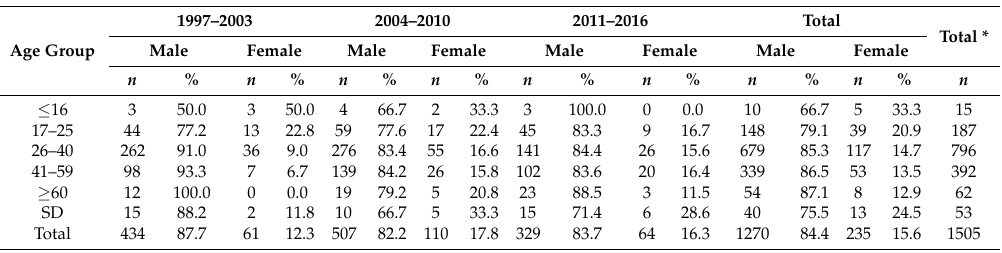
Table 2. Distribution of AIDS patients with cryptococcosis in Colombia, 1997–2016, according to age, sex, and study